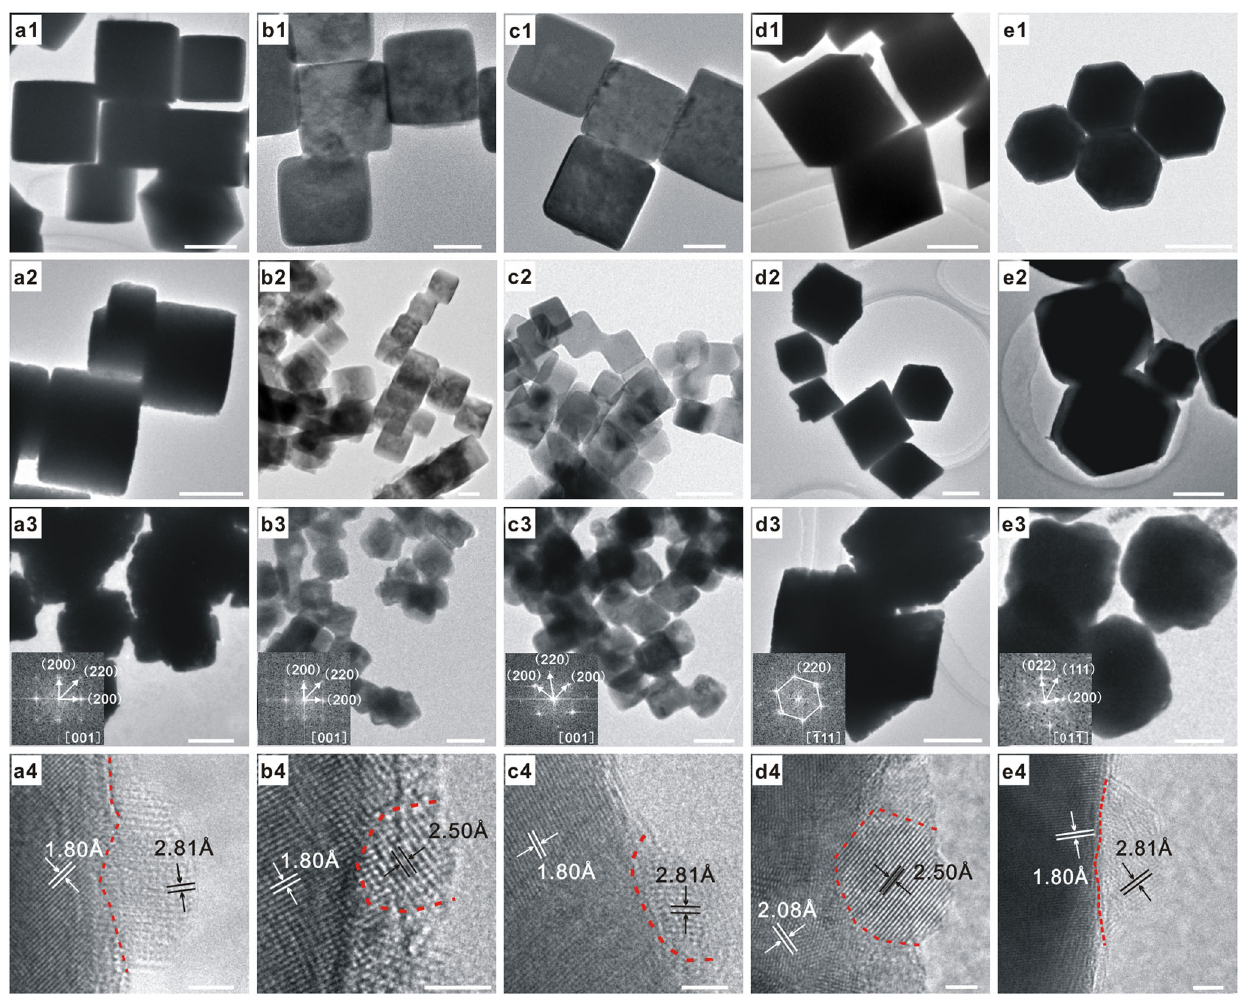
Fig. 1 Microscopic characterizations. The scale bars of ( a1 – a3 ), ( d1 – d3 ), and ( e1 – e3 ) correspond to 500 nm, that of b3 corresponds to 100 nm, those of b1 , b2 , c2 , and c3 correspond to 50 nm, that of c1 corresponds to 20 nm, and those of ( a4 – e4 ) correspond to 2 nm. TEM images of as-synthesized a1 c- Cu 2 O-682, b1 c-Cu 2 O-109, c1 c-Cu 2 O-34, d1 o-Cu 2 O, and e1 d-Cu 2 O NCs. TEM images of as-synthesized a2 1%ZnO/c-Cu 2 O-682, b2 1%ZnO/c-Cu 2 O- 109, c2 1%ZnO/c-Cu 2 O-34, d2 1%ZnO/o-Cu 2 O, and e2 1%ZnO/d-Cu 2 O catalysts. TEM and HRTEM images of as-synthesized ( a3 , a4 ) 1%ZnO/c-Cu-682, ( b3 , b4 ) 1%ZnO/c-Cu-109, ( c3 , c4 ) 1%ZnO/c-Cu-34, ( d3 , d4 ) 1%ZnO/o-Cu, and ( e3 , e4 ) 1%ZnO/d-Cu catalysts. Lattice fringes of 1.80, 2.08, 2.50, and 2.81 Å respectively correspond to the spacing of Cu{200}, Cu{111} (JCPDS card NO. 89-2838), hexagonal ZnO{101}, and ZnO{100} (JCPDS card NO 89- 1397) crystal planes. Insets show corresponding electron diffraction patterns of TEM